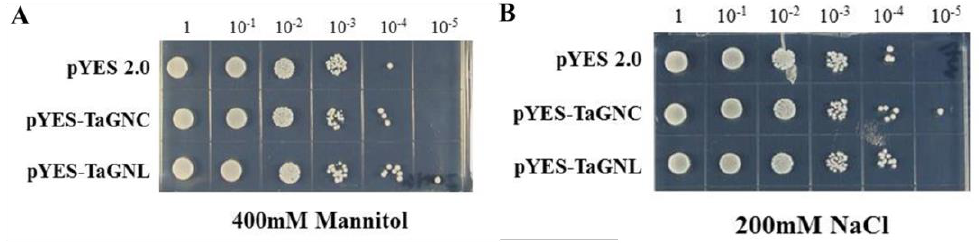
Figure 8. Growth states of transgenic yeast on selective media. The pYES2 empty vector was used as a negative control. ( A ) Yeast grew on SD/–Ura/400 mM mannitol medium. ( B ) Yeast grew on SD/–Ura/200 mM NaCl medium.